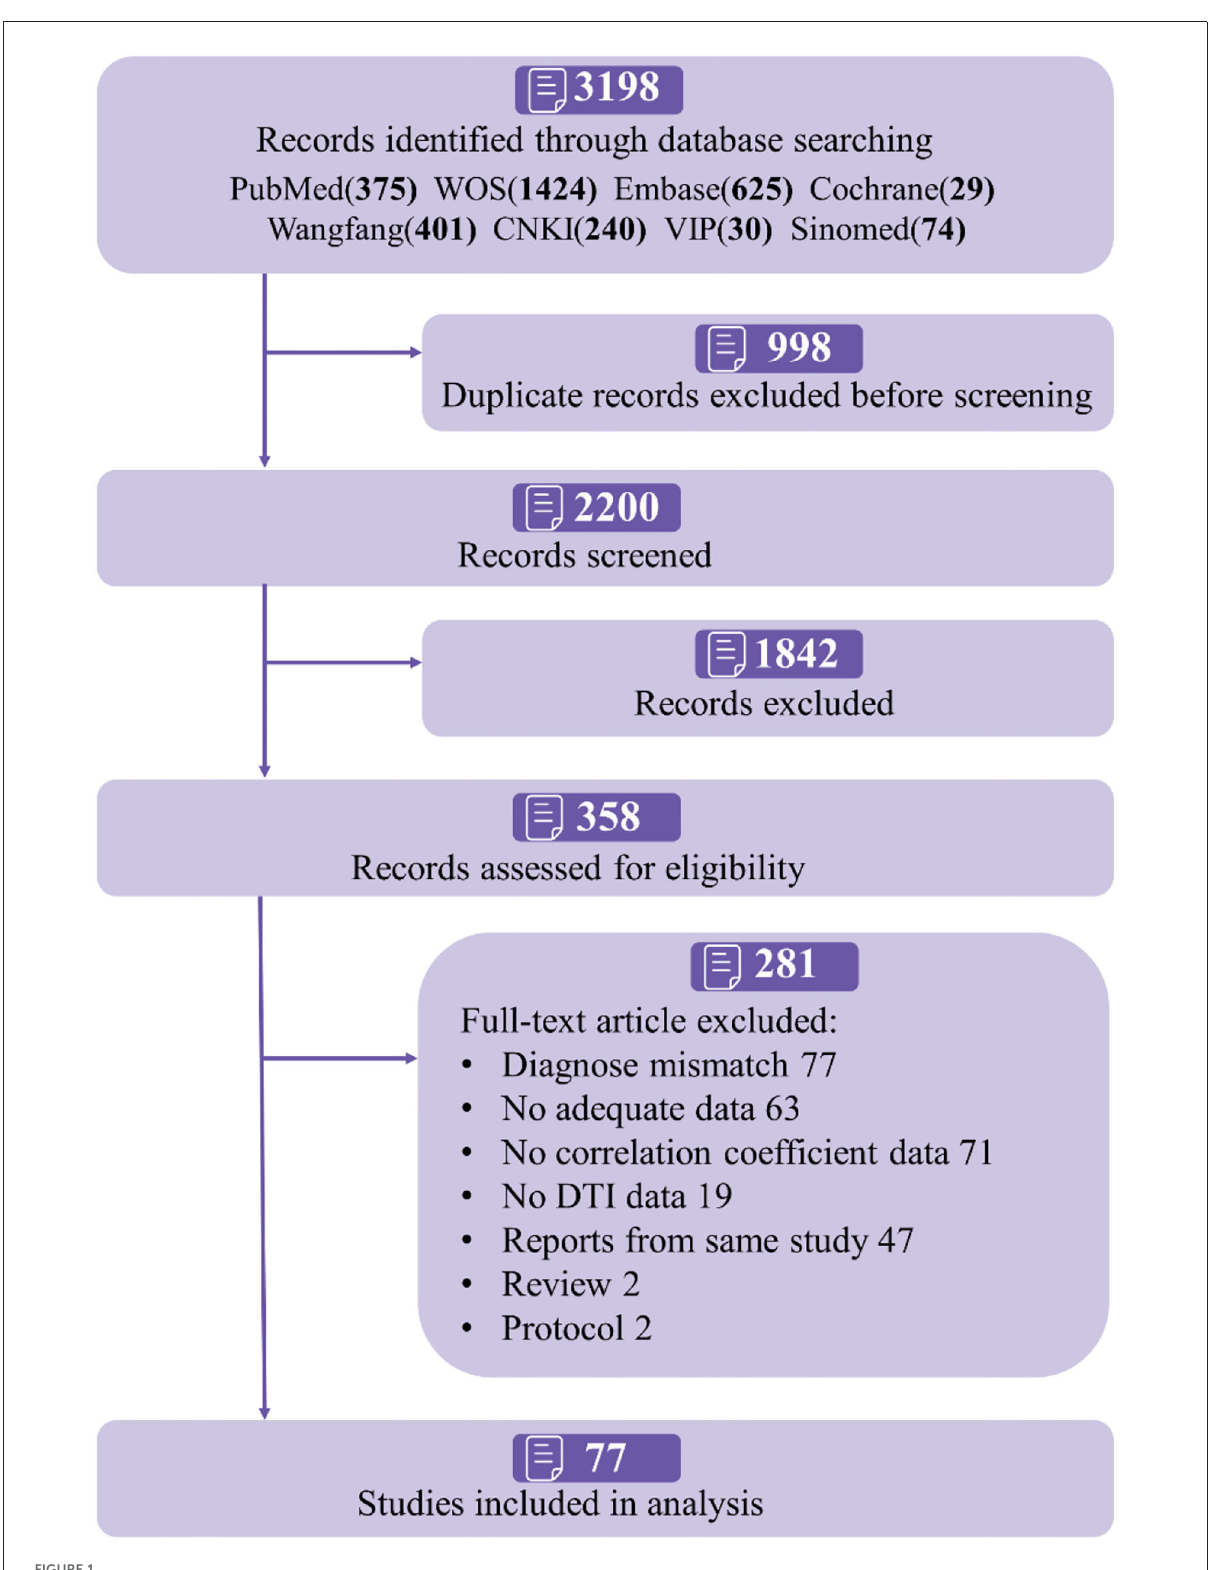
FIGURE1 Flowchart of study